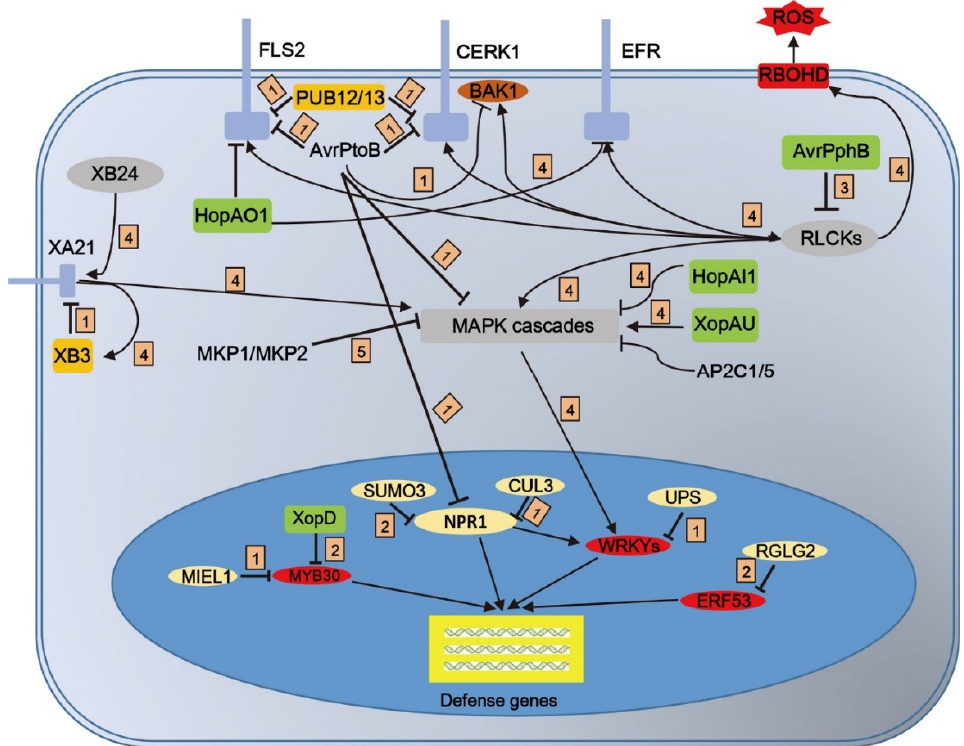
Figure 3. Schematic main PTMs in innate immunity of plants. Direct or indirect PTM activities plant immune response. PTM processes indicated are: 1, Ubiquitination/De-ubiquitination; 2, SUMOylation/De- SUMOylation; 3, cysteine protease; 4, Phosphorylation/De-phosphorylation